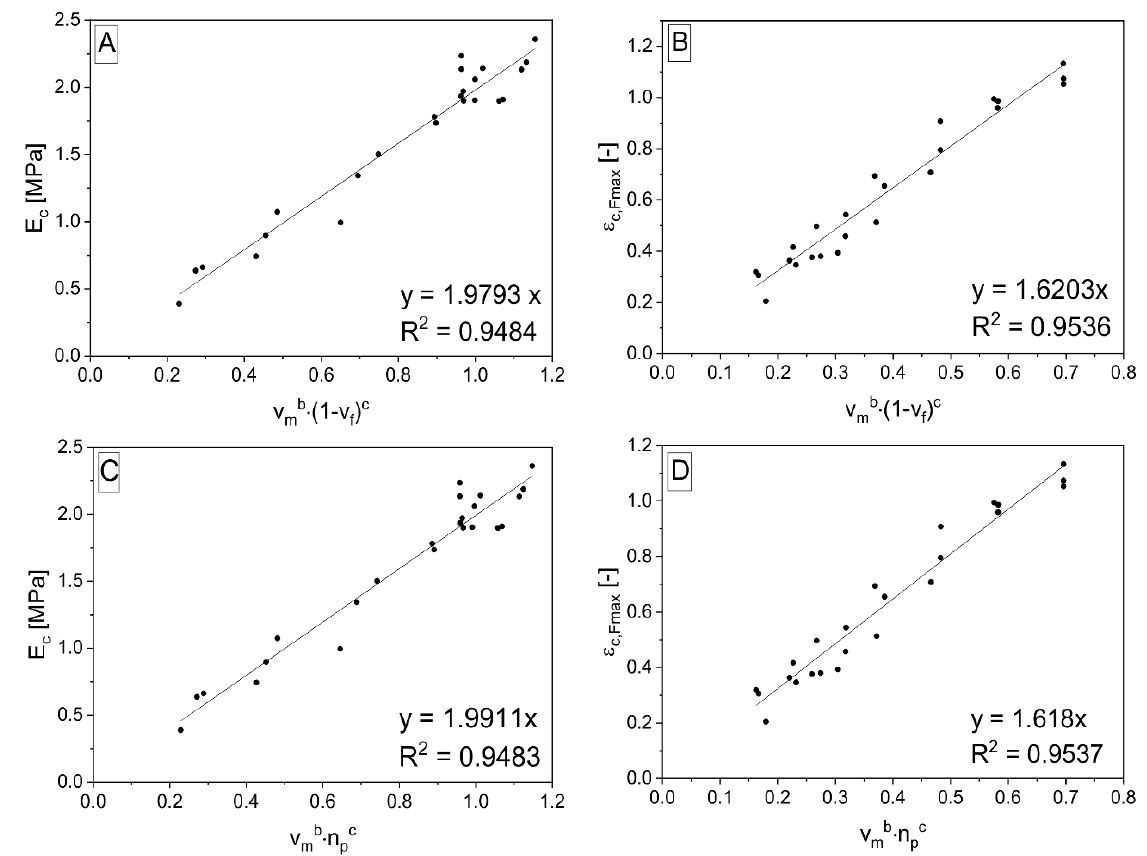
Figure 5. Linear fitting of plot between selected mechanical properties of porous composites com- posed of P 85 -G 5 -CO 10 matrix filled by different fractions of rubber: E ( A , C ), ε Fmax ( B , D ); and expres- sions v mb ( 1 − v f ) c ( A , B ) and v m b · n pc ( C , D ) — data fitted according to Equations (10) and (11).